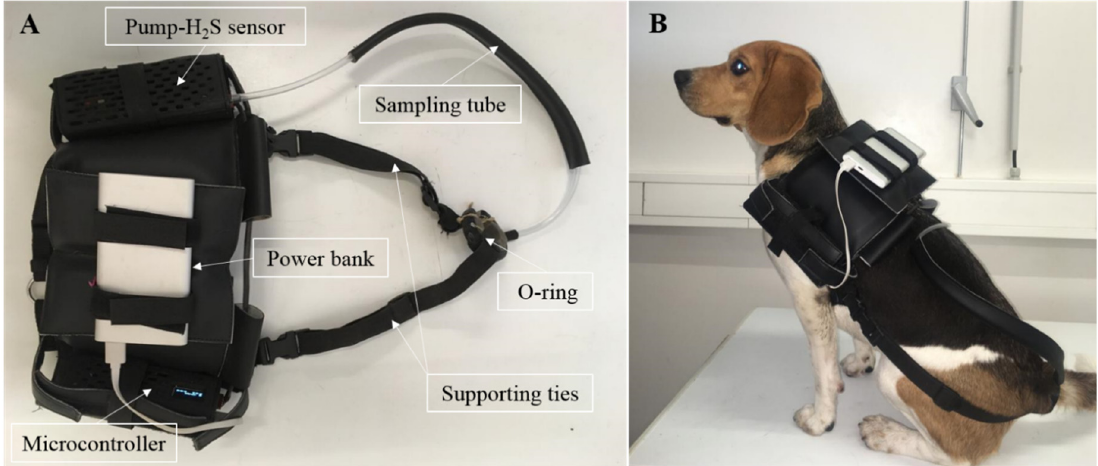
Figure 1. Real image of the vest assembled device used for flatulence assessment based on H 2 S measurement in the anal region ( A ); dog wearing the vest ( B ).